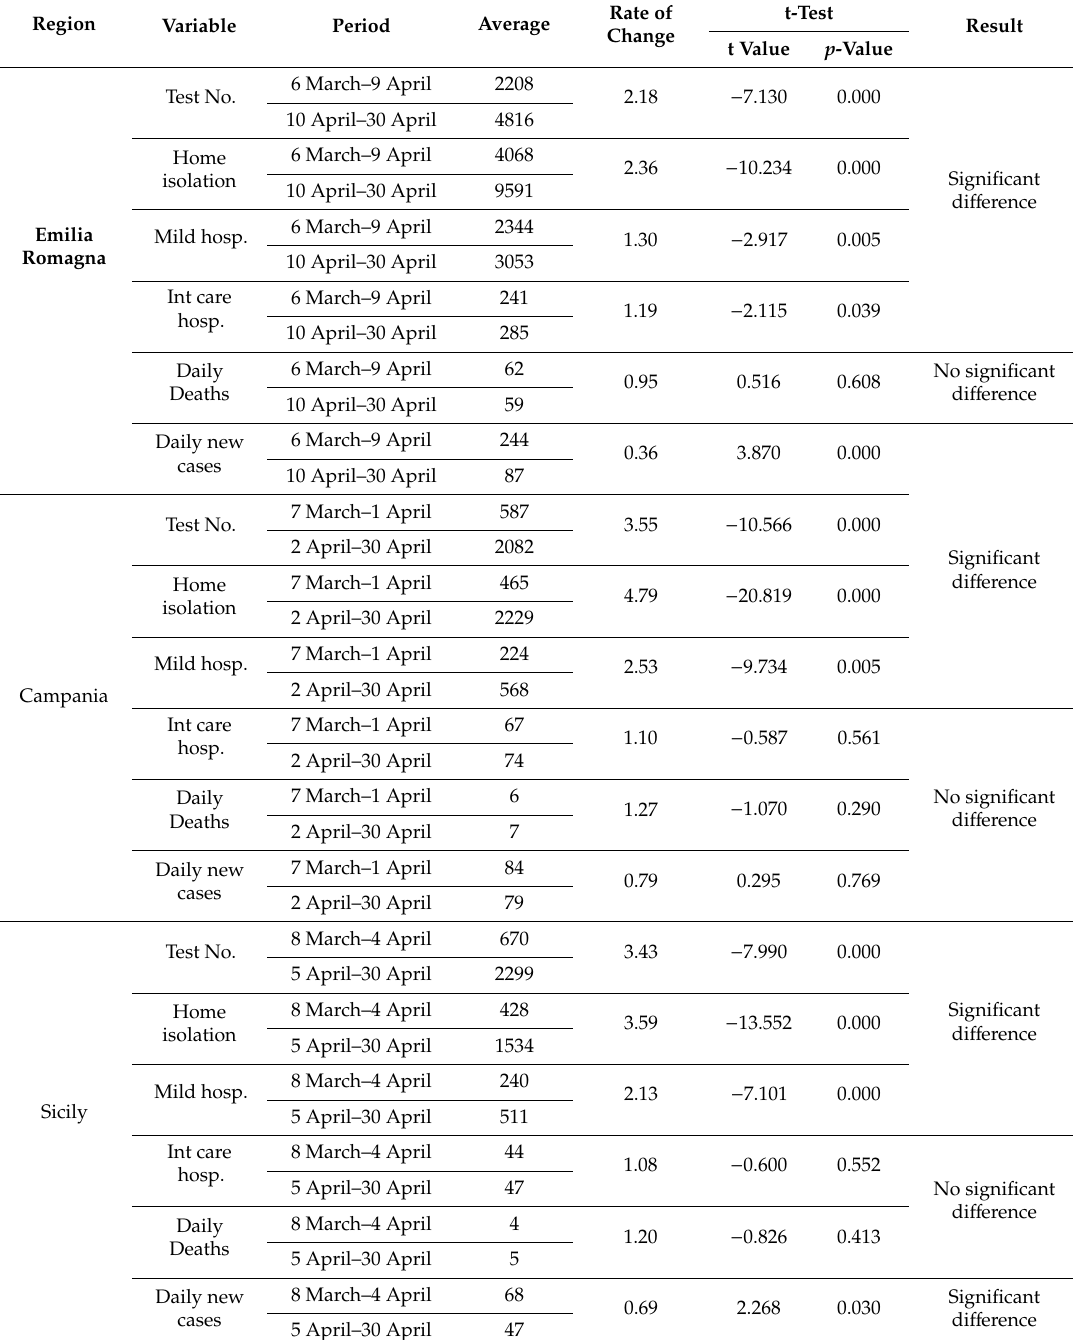
Table 6. T-test results within two periods (Emilia–Romagna, Campania, and Sicily).